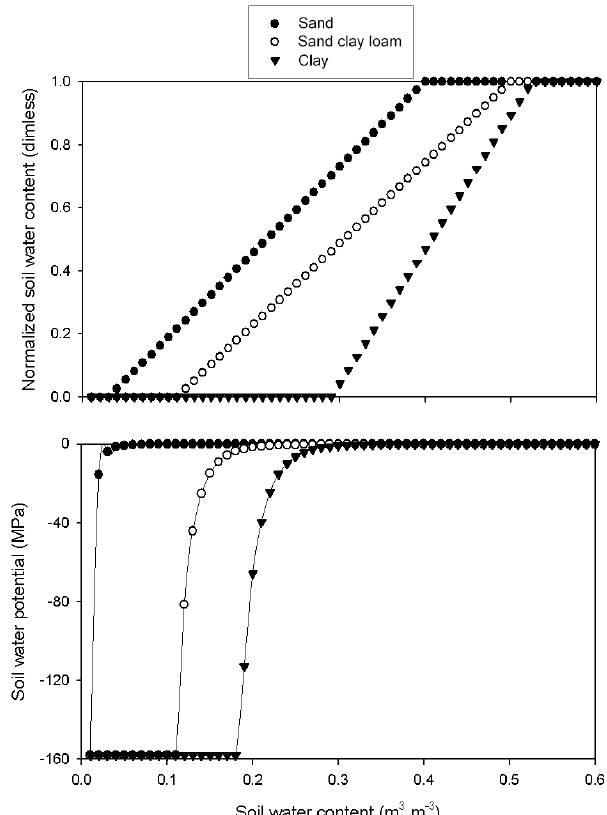
Figure 1. Dependence of normalized soil water content (upper part) and soil water potential (lower part) on soil water content in the case of three different soil types. Dimless indicates dimensionless